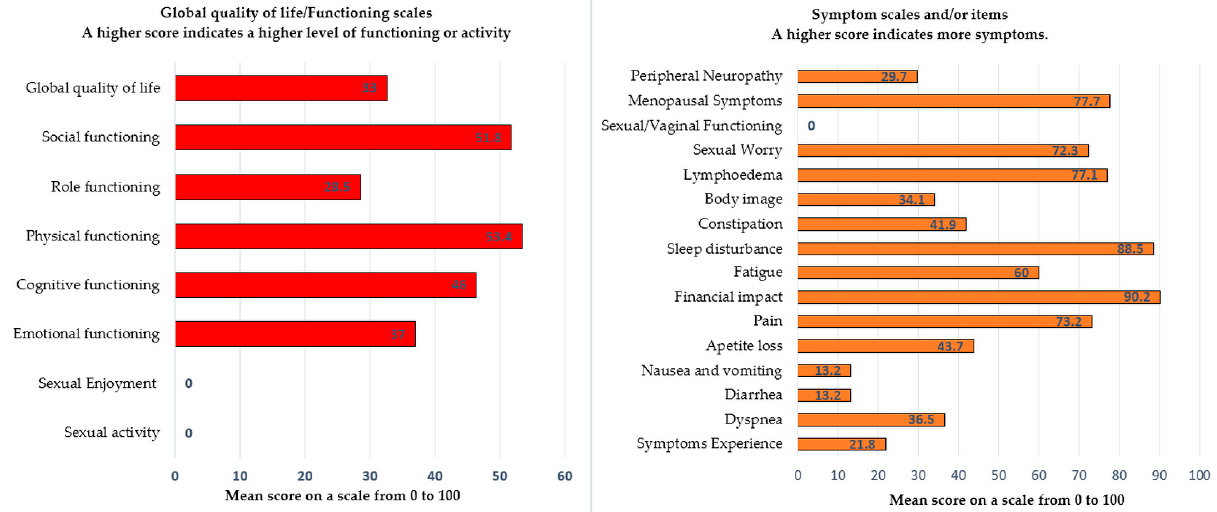
Figure 2. The QoL of the 18 patients who answered the EORTC QLQ-C30 and EORTC QLQ-CX24 who underwent pelvic exenteration.